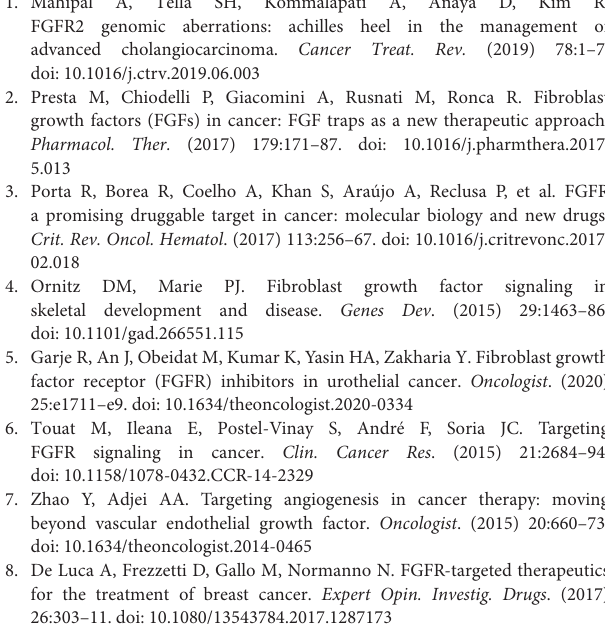
Supplementary Figure 3 | Forest plot for the association between FGFR2 expression and patient progression-free survival (PFS). Supplementary Table 1 | Summary of TCGA cancer types and sample size.